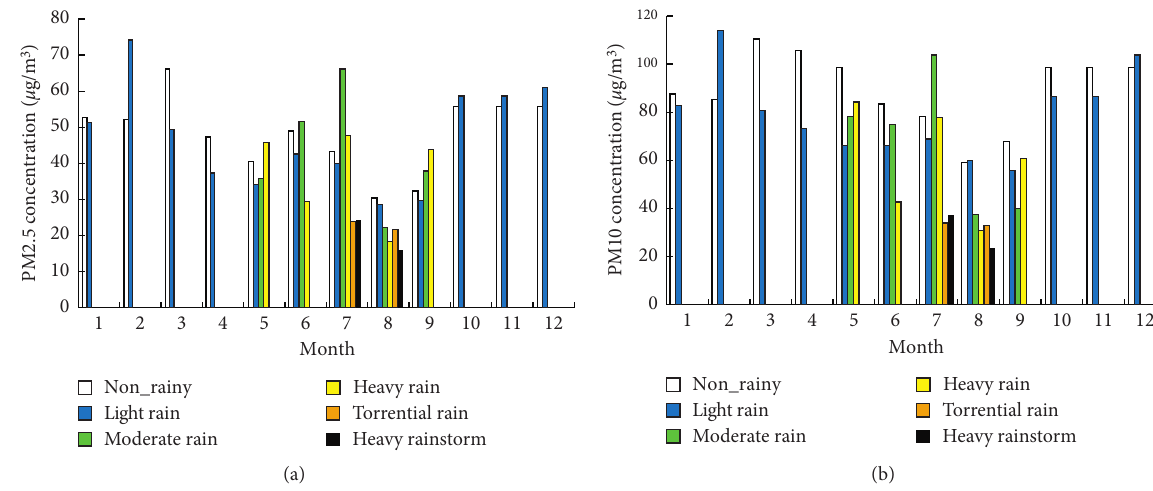
Figure 4: Monthly averaged PM2.5. (a) PM10. (b) Mass concentration between different precipitation intensities at Qinhuangdao from 2016 to 2018: nonrainy (white hollow column), light rain (blue column), moderate rain (green column), heavy rain (yellow column), torrential rain (orange column), and heavy rainstorm (black column).